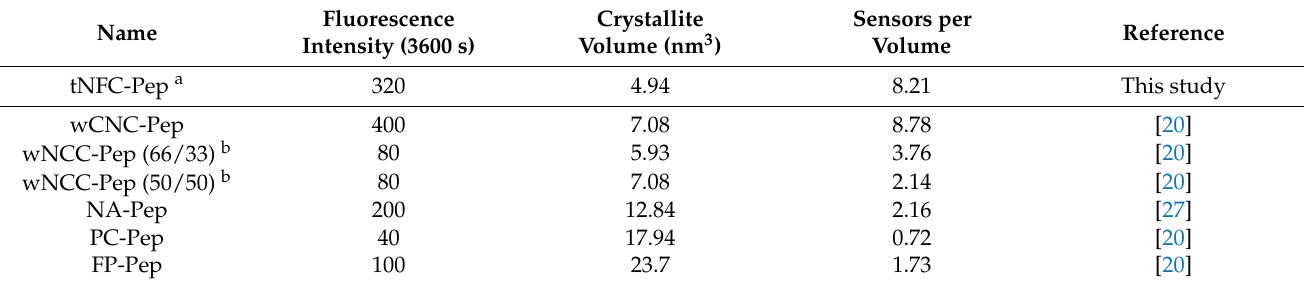
Table 1. Fluorescence intensity of cellulose and nanocellulose materials and corresponding number of sensors per unit